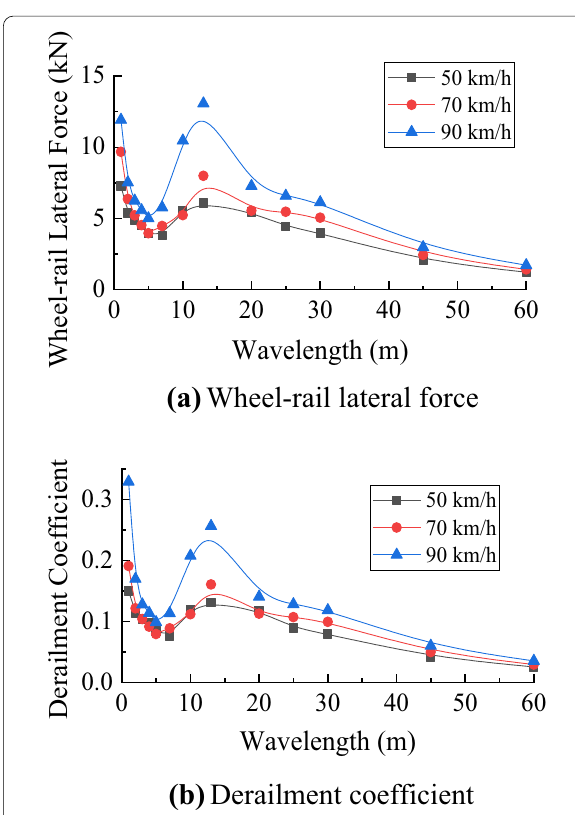
(b) Derailment coefficient Figure 6 Influence of 10 mm gauge irregularity wavelength amplitude on derailment coefficient and wheel-rail lateral